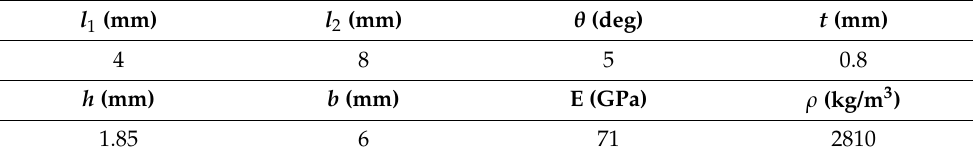
Table 1. Main parameters of the series bridge